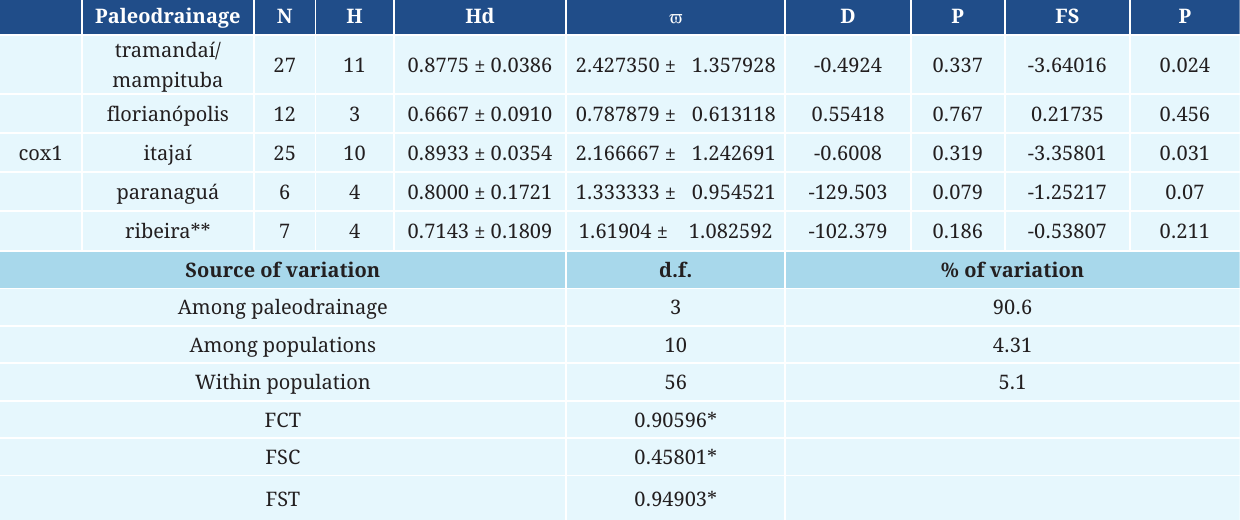
TABLE 2 | Genetic diversity of cox 1: sample size (N), haplotype number (H), haplotype diversity (Hd), mean number of pairwise differences (π), D of Tajima statistic (D) and FS test (FS). *Value of P <0.001; **Population not considered for the AMOVA analyses.